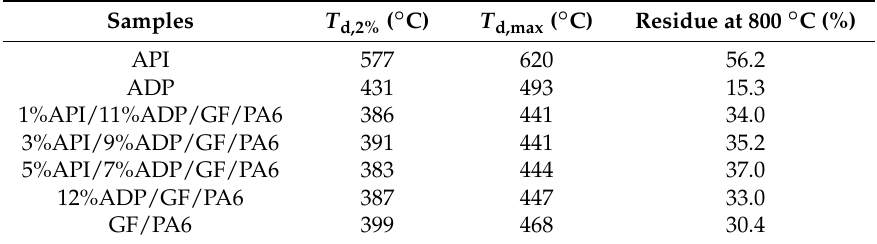
Figure 1. TGA curves for API, ADP and PA6 composites. Table 2. Typical TGA data for API, ADP and PA6 composites.